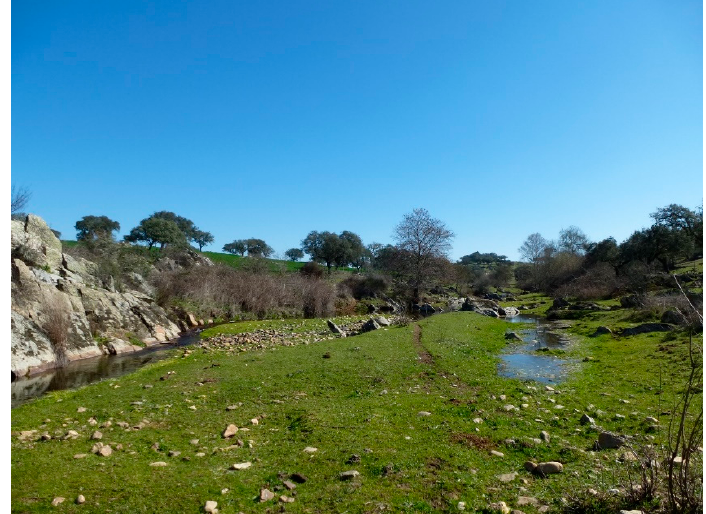
Figure 5. Caia riverbed, with the riparian vegetation within the agricultural landscape (author: Kaletová, 2018).